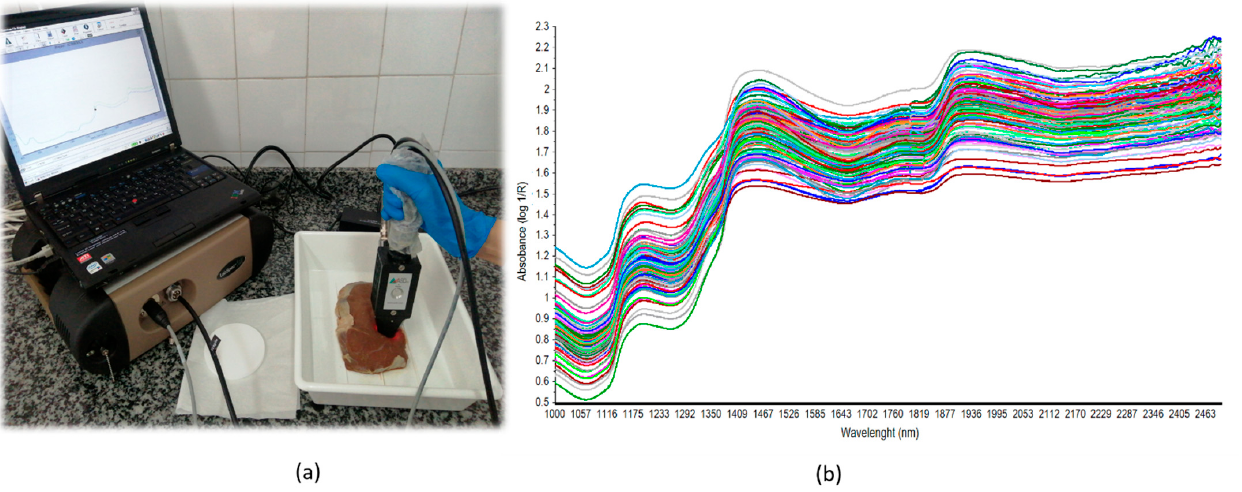
Figure 1. NIR spectrum acquisition system. ( a ) LabSpec 5000 fitted with a fiber optic contact probe (ASD Inc., Boulder, CO, USA); ( b ) absorbance spectra of all samples included in the study (1000–2500 nm). Different color lines represent each different spectra.